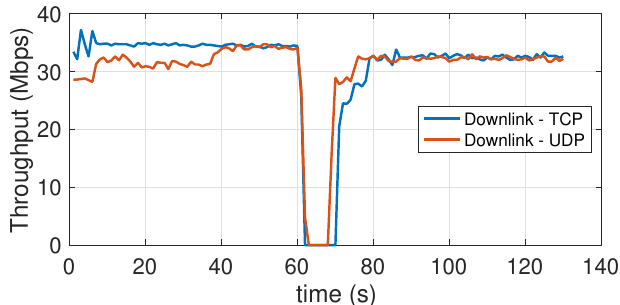
Figure 18. Downlink throughput during an handover across close-by attocells. TCP and UDP.